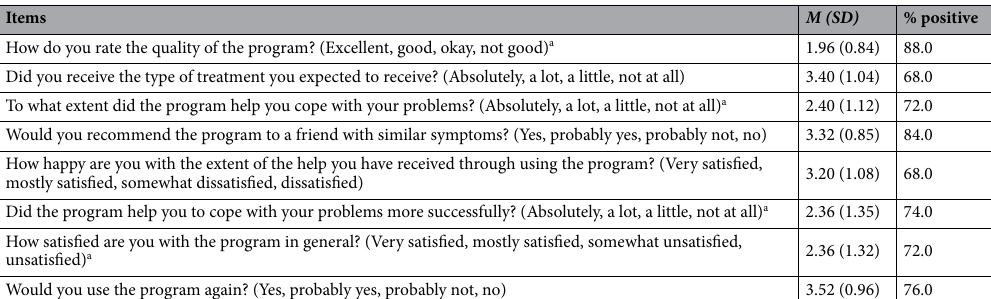
Table 5. Subjective appraisal of Restart based on the German version (ZUF-8) of the Client Satisfaction Questionnaire (CSQ-8; n = 25). a A lower score indicates more positive answers (inverted